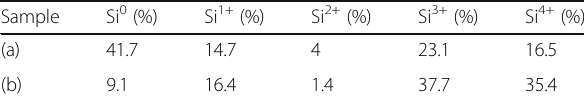
Table 1 Percentages of Si oxidation states by XPS measurements